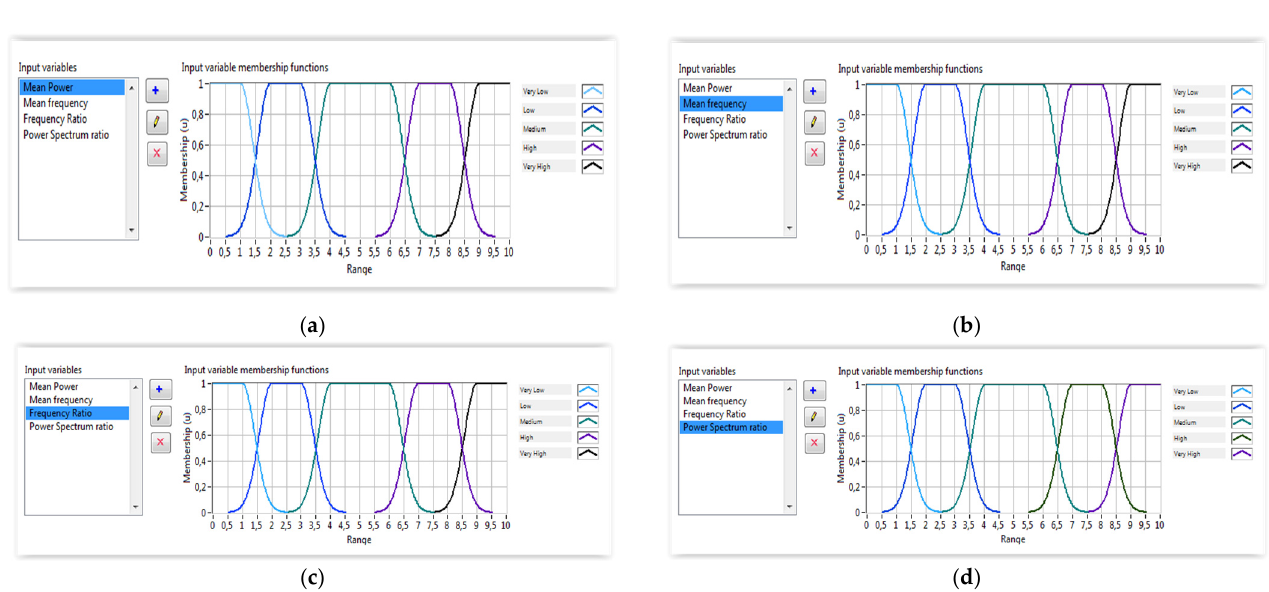
Figure 10. Inputs fuzzy membership functions: ( a ) EMG-MP; ( b ) EMG-MF; ( c ) EMG-FR; ( d ) EMG- FSR.